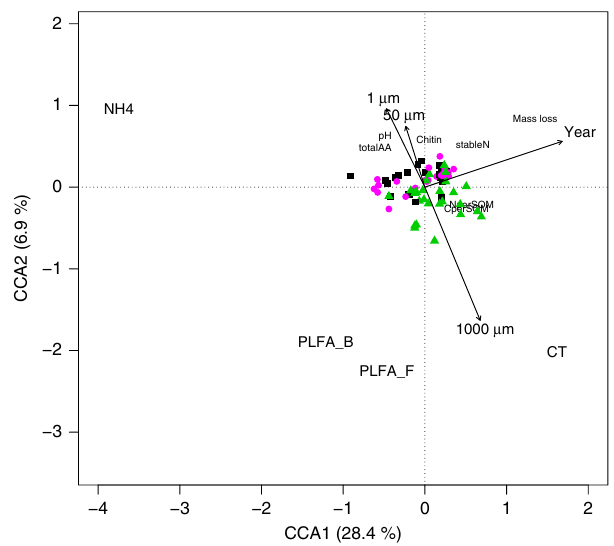
Fig. 1 Effect of the treatments and time on chemical and biological soil properties. Partial constrained correspondence analysis (pCCA) illustrates the effect of the three treatments and experimental time (year) on the chemical and biological compositions of the mesh bags. The CCA1 axis explains 28.4% ( P ≤ 0.001, F = 31.36) of the data variability, and the CCA2 axis explains 6.8% ( P ≤ 0.001, F = 7.59) of the data. The different mesh treatments are represented with a green triangle (1000 µ m mesh), magenta circle (50 µ m mesh) and black square (1 µ m mesh). The variables responsible for the separation of the different samples in the analysis have been marked on the diagram with the following abbreviations: total AAs total free amino acids, CT condensed tannins, stableN stable SOM-nitrogen (N) pool, SOM soil organic matter, NH 4 ammonium, PLFA_B bacterial phospholipid fatty acids (PLFA), PLFA_F fungal